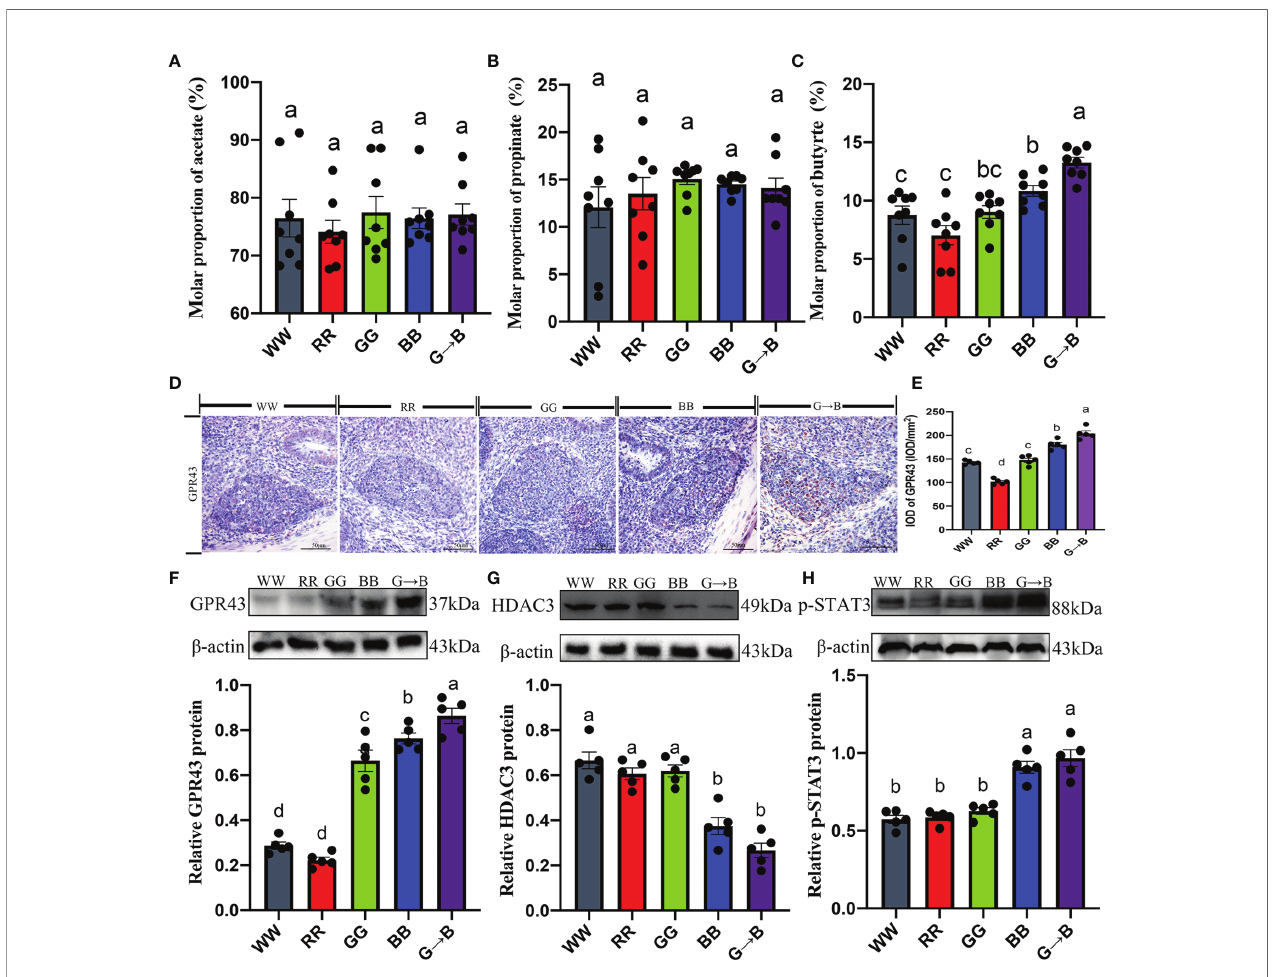
FIGURE 10 | Effects of different monochromatic light combinations on the cecum acetate concentration (A) , cecum propionate concentrations (B) , cecum butyrate concentration (C) , photomicrographs of the immunostaining of butyrate receptor subtypes GPR43 in the cecal tonsil at P42 (D) , the integrated optical density of GPR43-positive cells (E) , GPR43 protein expression (F) , HDAC3 protein expression (G) , and p-STAT3 protein expression (H) in the cecal tonsil at P42. WW, white light; RR, red light; GG, green light; BB, blue light; G ! B, green light and blue light combination. The results are presented as means ± SEM. Different letters indicate signi fi cant differences between the treatments at the same age ( P <